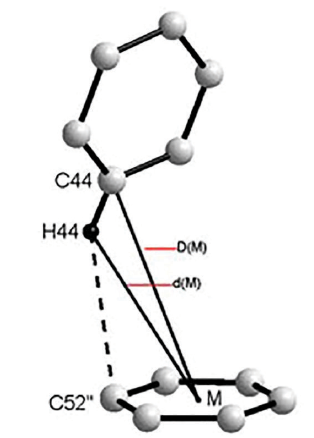
FIGURE 3 - Projection of fragments involved in the non classical aromatic hidrogen bondings C-H ∙∙∙ Ph of the dimers of the C31-C36 / C51'-C56 'complex. [Symmetry Code x-1, y-2, z]. Hydrogen atoms are omitted for better layout view. M = centroid point of the aromatic ring.